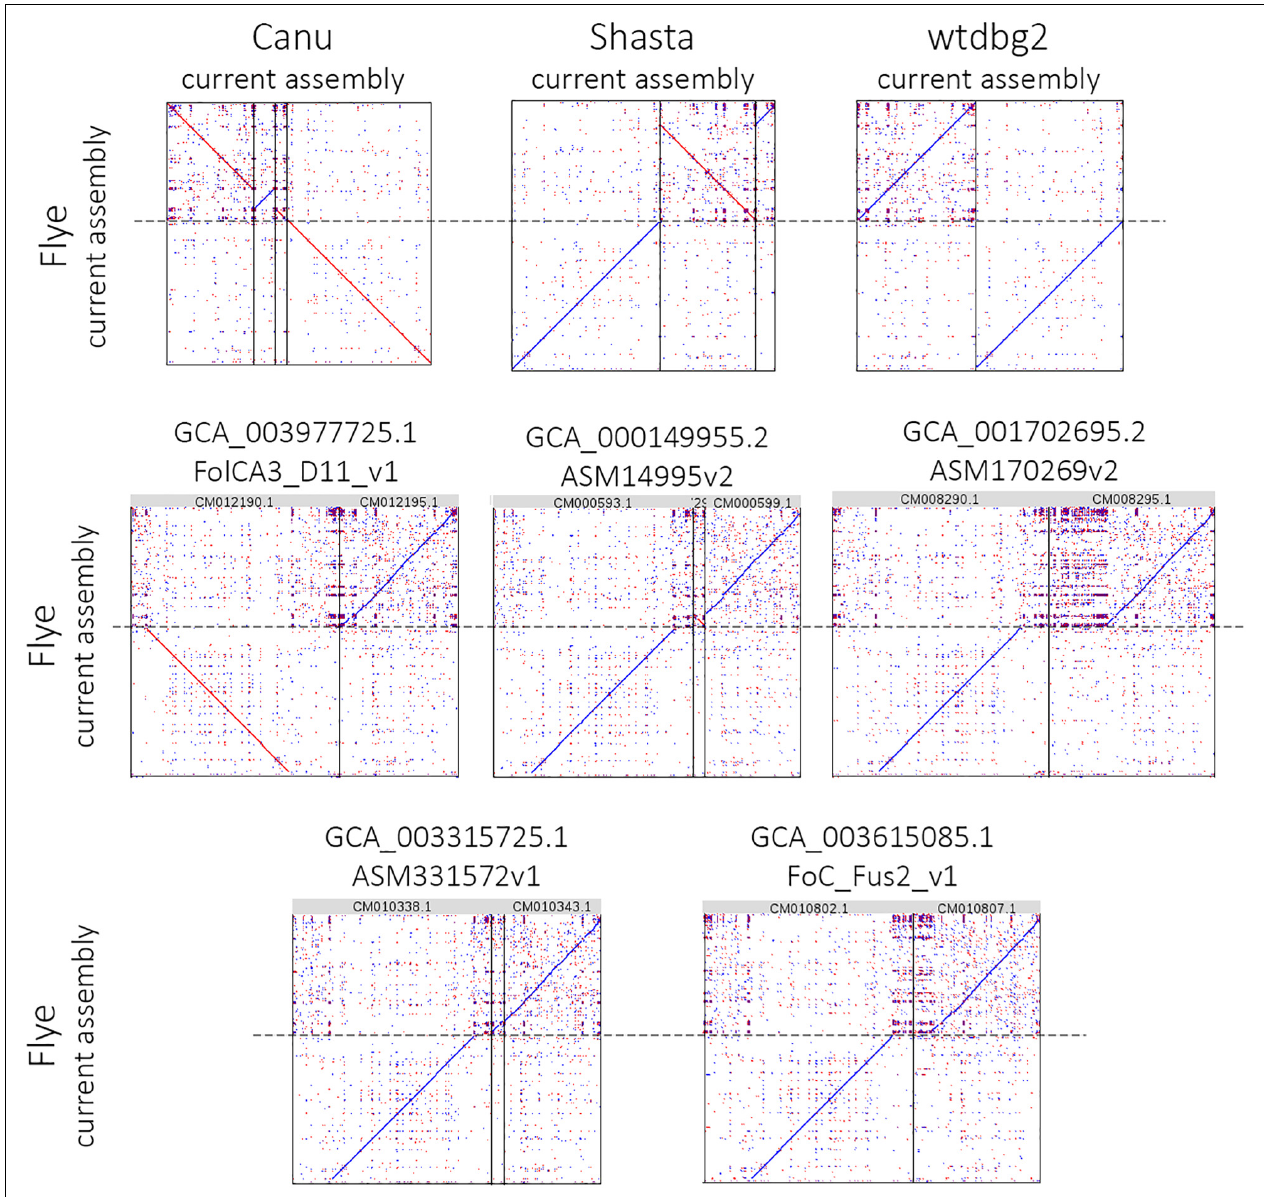
FIGURE 2 | Alignment of the largest Flye 2.6 contig to Canu 1.8, Shasta 0.4.0, wtdbg2 2.5 assemblies and five NCBI chromosome-level assemblies of Fusarium oxysporum strains. The chromosome-level assemblies of F. oxysporum strains can be found in the NCBI Genome database (https://www.ncbi.nlm.nih.gov/